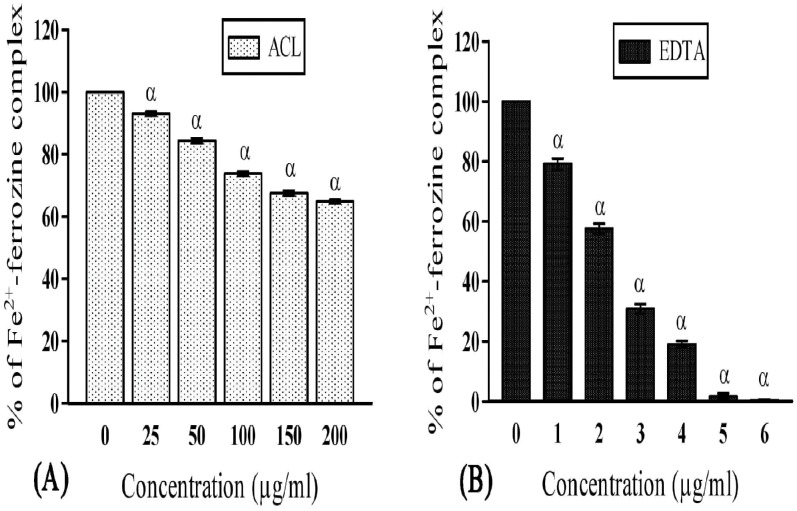
Iron (Fe2+)-chelation activities of ACL extract and the reference compound.(A) ACL extract and (B) standard Ethylenediaminetetraacetic acid (EDTA), represented as % of Fe2+-ferrozine complex (IC50 value: ACL = 320.63±10.82μg/ml and EDTA = 1.45±0.01μg/ml; p<0.001). [Each value represents mean ±SD (n = 6); Where, α = p<0.001 Vs 0 μg/ml].